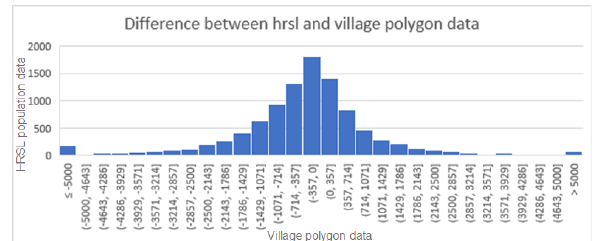
Figure 1. Difference of HRSL population data and village polygon data with official figures for each village. Some villages lack the official figures.